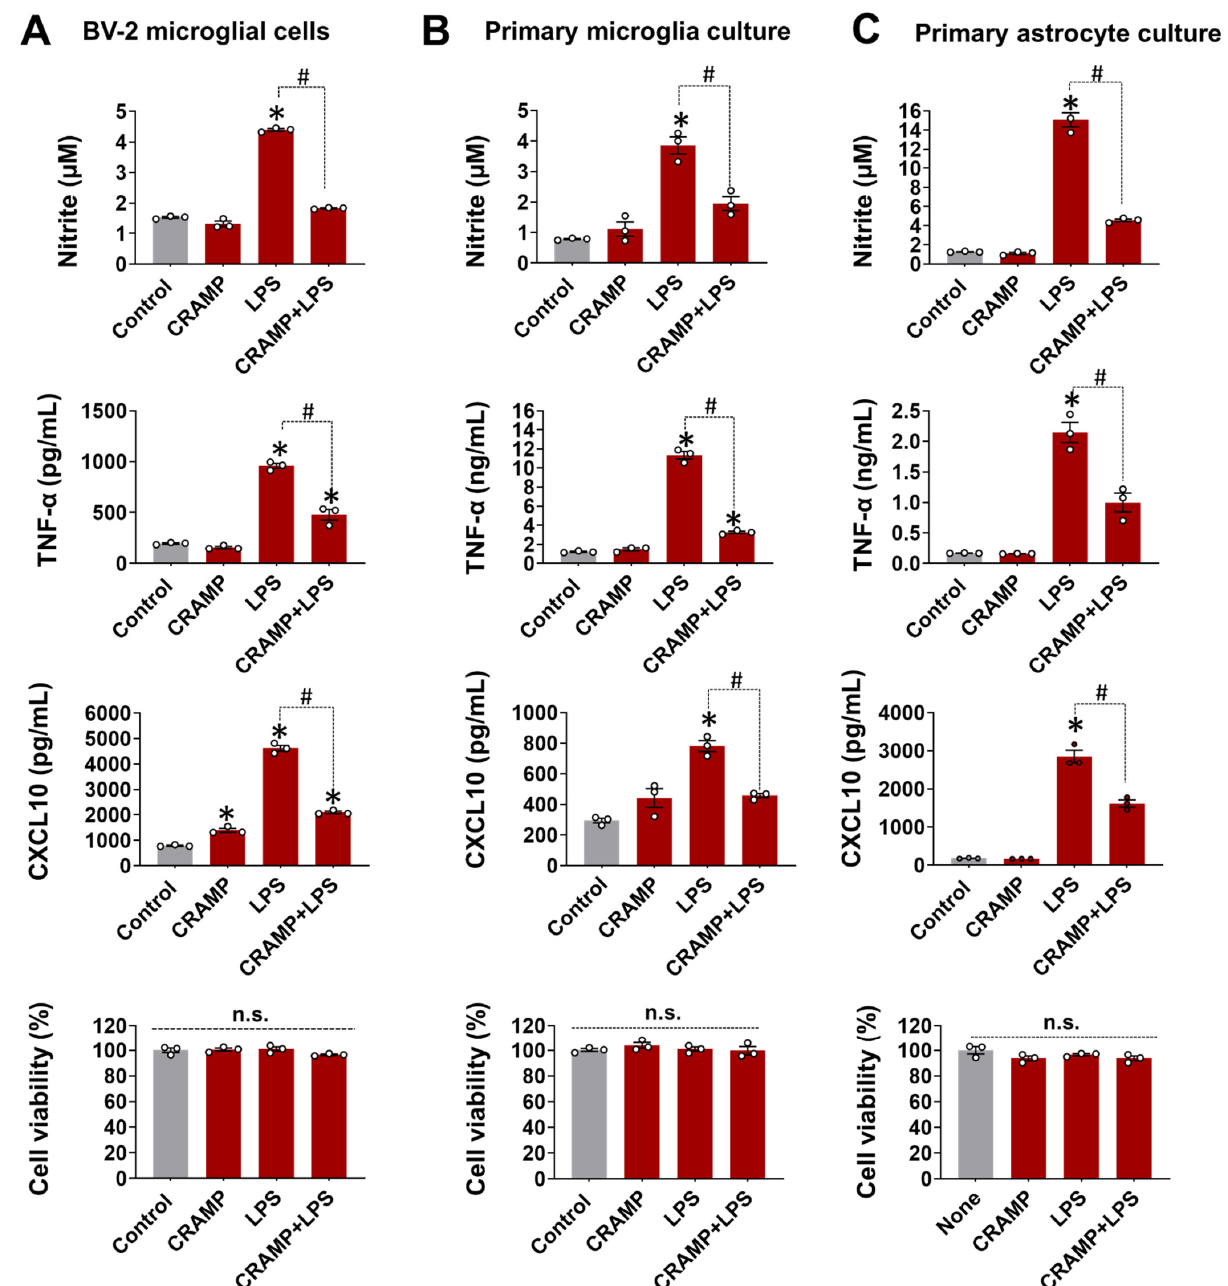
Figure 1. CRAMP peptide treatment suppresses LPS-induced glial activation. The effect of CRAMP peptide (30 µg/mL) treatment on LPS-induced production of NO, TNF- α , and CXCL10 was deter- mined in BV-2 cells ( A ), primary microglia ( B ), and astrocytes ( C ) at 24 h, either by nitrite measurement or ELISA. MTT assay was utilized to assess cell viability, which showed no difference between treatment groups. Data are mean ± SEM; n = 3; * p < 0.05 versus control; # p < 0.05 between specified groups. One-way ANOVA with Tukey’s post hoc test. n.s., not significant. Studies have shown that CRAMP-mediated inflammatory responses generally de- pend on the timing and sequence of exposure to CRAMP and other stimuli [17]. To ad- dress this aspect, we performed CRAMP peptide co-, pre-, and post-treatment to LPS- stimulated BV-2 microglial cells and measured NO levels as a representative molecule for